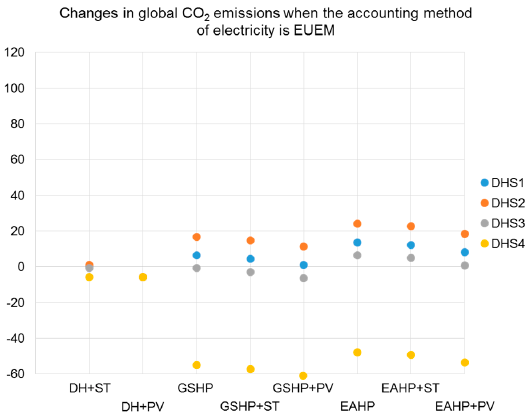
Figure 5. The changes in global CO 2 emissions for different heating sources and if an ST or a PV system is used, compared to if the building is heated with DH only. The four different compositions of DHS presented in Table 4 are compared and the allocation for changes in electricity use/production is the EUEM. The yellow DHS 4 marking for DH + PV represents all four systems.